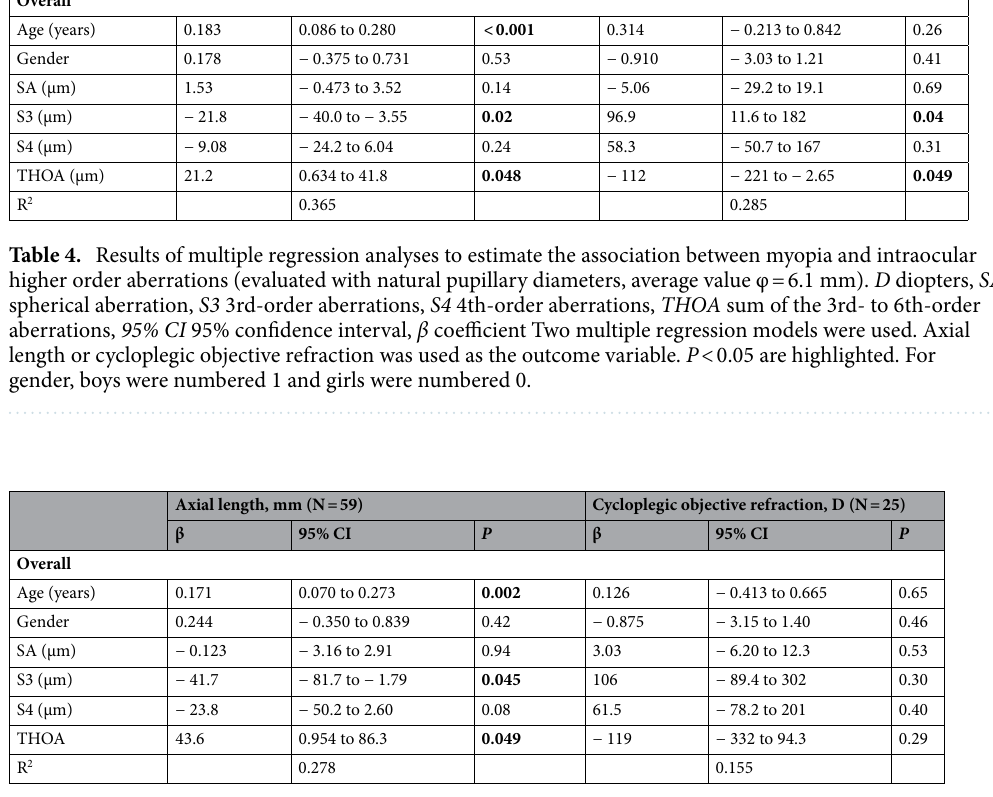
Table 5. Results of multiple regression analyses to estimate the association between myopia and total ocular higher order aberrations (evaluated with natural pupillary diameters, average value φ = 6.1 mm). D diopters, SA spherical aberration, S3 3rd-order aberrations, S4 4th-order aberrations, THOA sum of the 3rd- to 6th-order aberrations, 95% CI 95% confidence interval, β coefficient. Two multiple regression models were used. Axial length or cycloplegic objective refraction was used as the outcome variable. P < 0.05 are highlighted. For gender, boys were numbered 1 and girls were numbered 0.